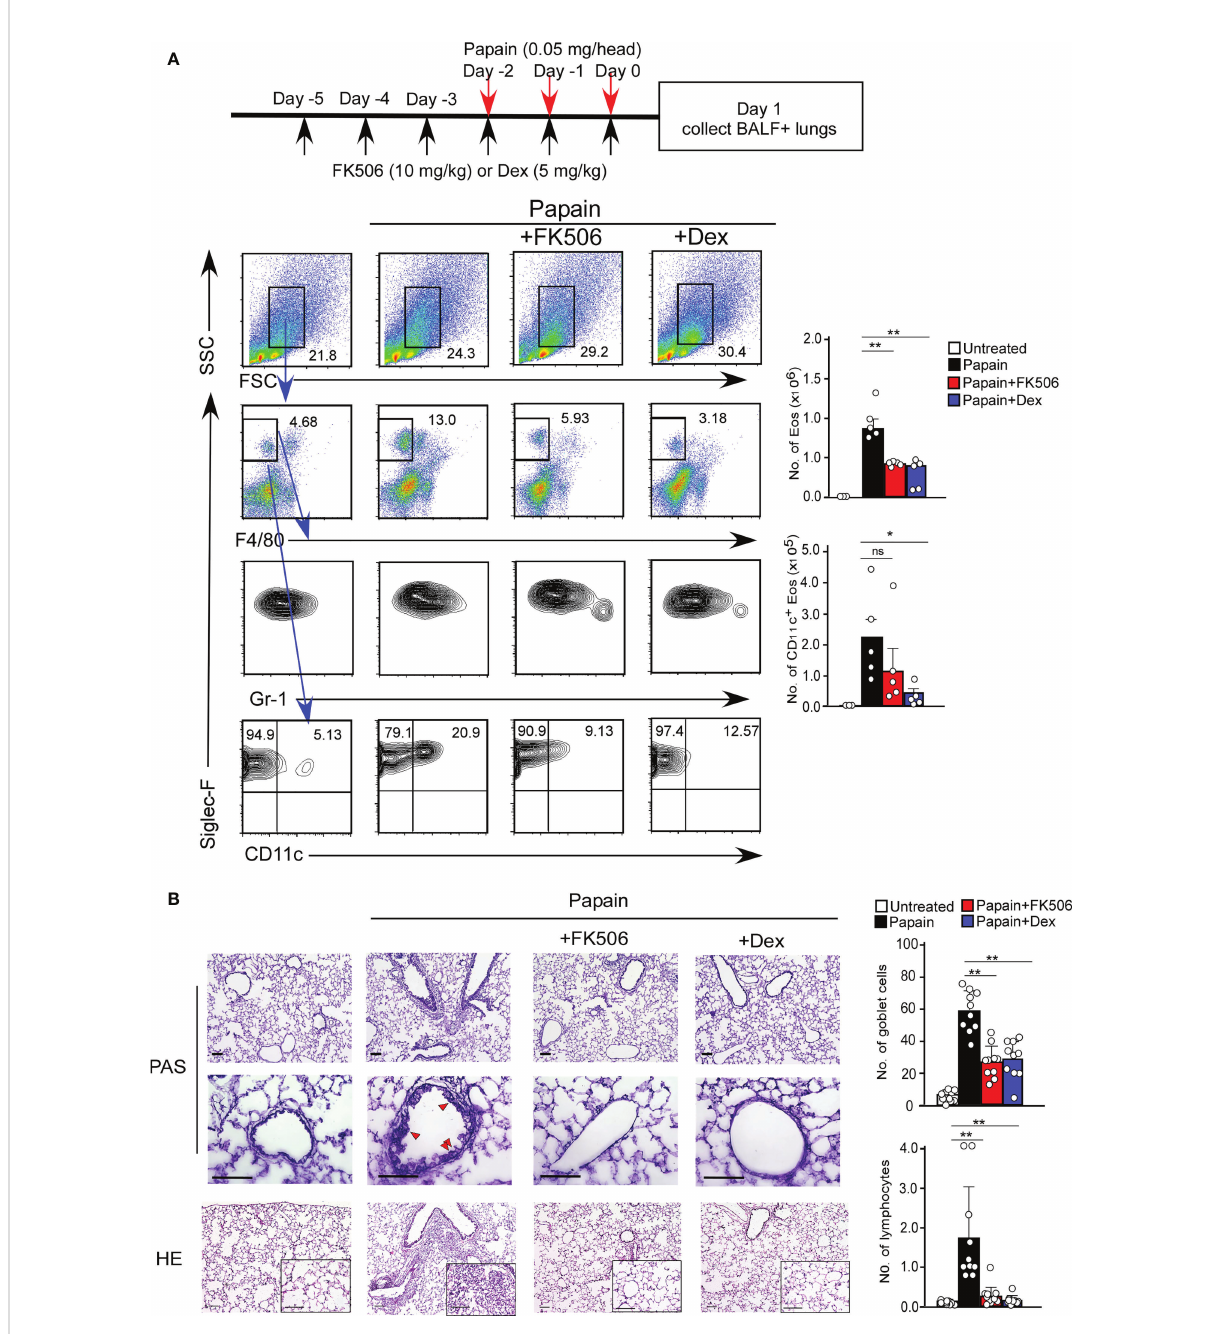
FIGURE 1 (A) The papain and FK506 or Dexamethasone (Dex) treatment protocol is presented by the schematic diagram (top). The mice were administrated with (black bars, n=5) or without (white bars, n=5) papain. Papain-administrated mice were further treated with FK506 (red bars, n=8) or Dex (blue bars, n=5). Lung cells were prepared from the lung homogenate on day one after the fi nal papain injection (see Materials and Methods). Flow cytometry analysis assessed the percentage (left fl ow pro fi les) and cell numbers (right graphs) of Siglec-F+ and CD11c+ eosinophils (Eos). (B) PAS (top: low magni fi cation; middle: high magni fi cation) and HE (bottom) staining of lung sections from FK506- or Dex- treated mice. Red arrow heads indicate mucus glycans positive goblet cells. Goblet cells and lymphocytes were counted in 200 µm × 200 µm regions in each lung section (bar graphs, n=10). Bars represent the means; not signi fi cant (ns), *p – 0.05, **p – 0.01 using unpaired Mann-Whitney U-tests. All error bars represent SEM. Scale bars, 100 µm. FACS and section dates are representative of three